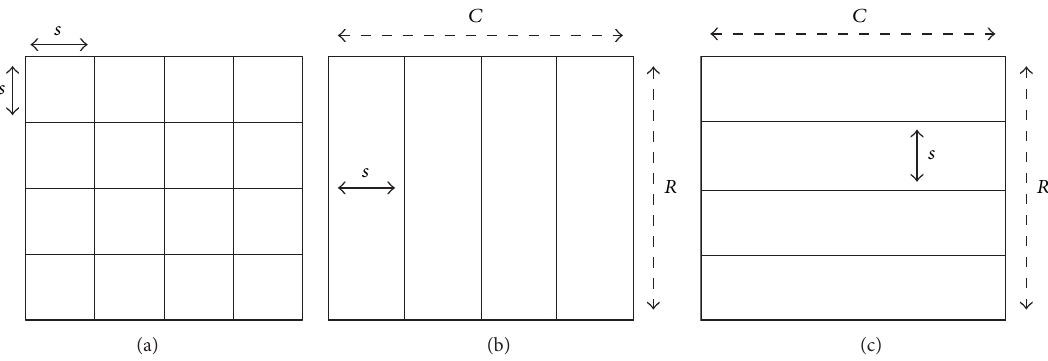
Figure 2: Structure of (a) rectangular HOG as in [14], (b) vertical HOG (V-HOG), and (c) horizontal HOG (H-HOG).